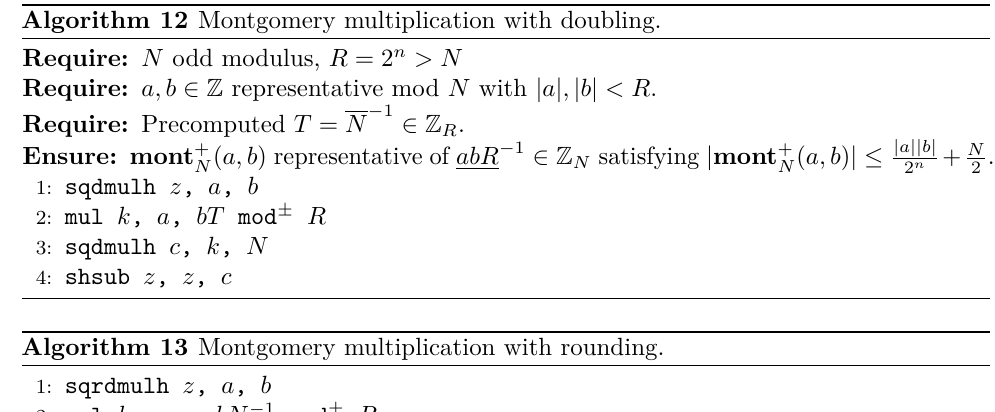
Algorithm 12 Montgomery multiplication with doubling.